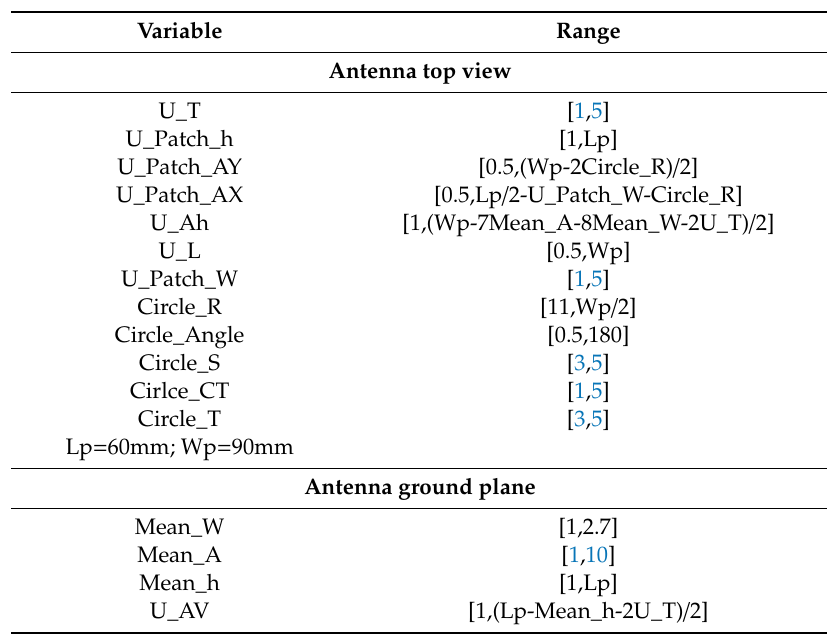
Table 1. Definition of the variables to optimize in the design of the proposed antenna (see Figure 1 for details).